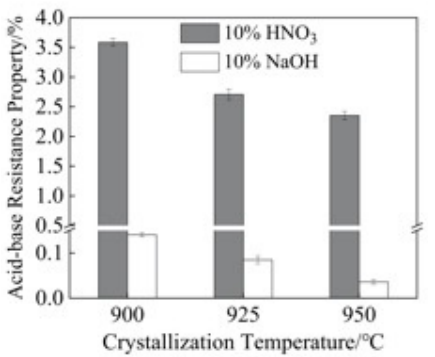
Figure 9. Effects of the crystallization temperature on the acid and alkali resistances of the microcrystalline glass.